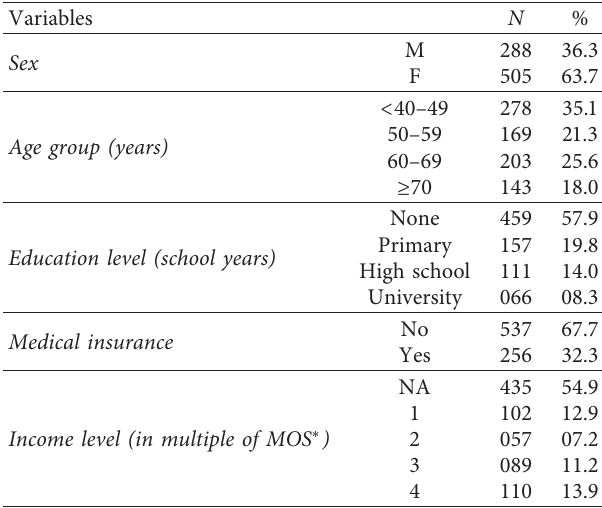
Table 1: Sociodemographic characteristics of the sample of 793 patients in the CVR assessment study.